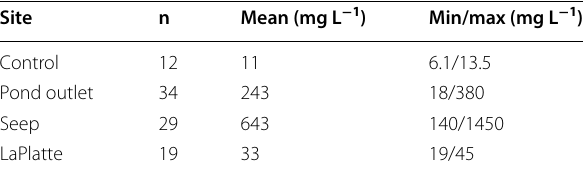
Table 1 Water grab sample summary for study locations